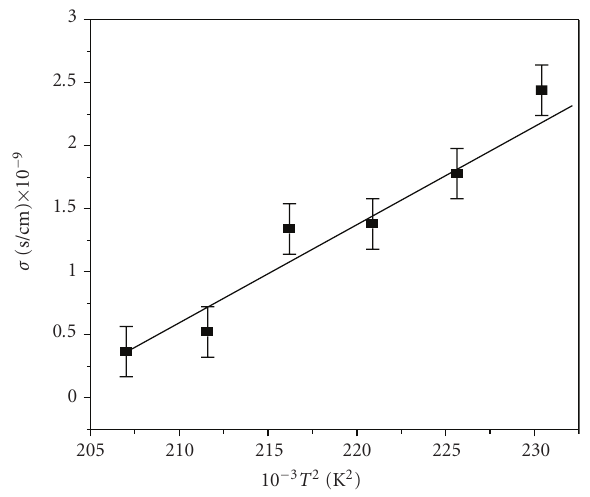
Figure 8: Plot of σ versus T 2 in the range 460–480 K where E a ∼ 0 . 77eV.